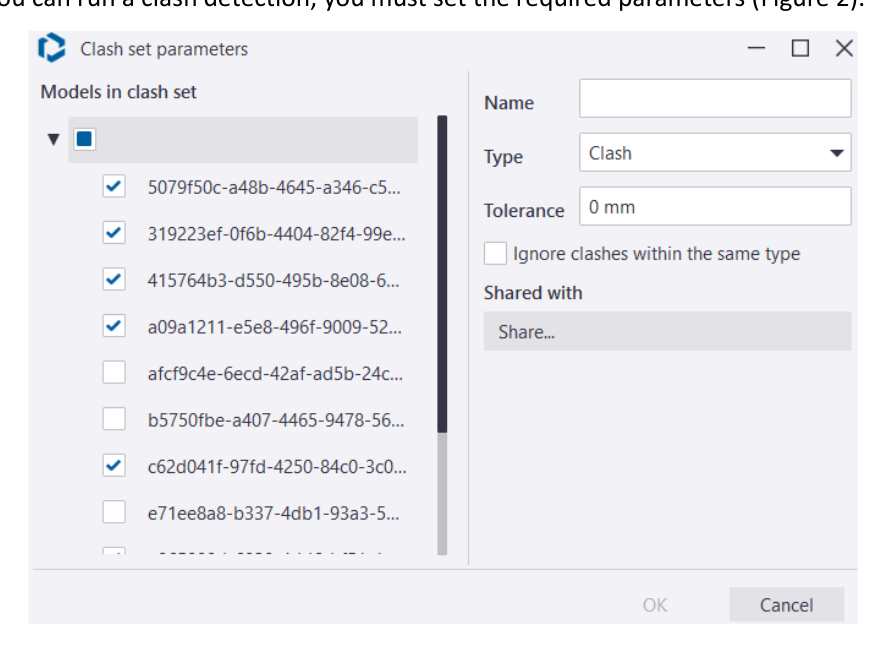
Figure 2: Setting clashes parameters,